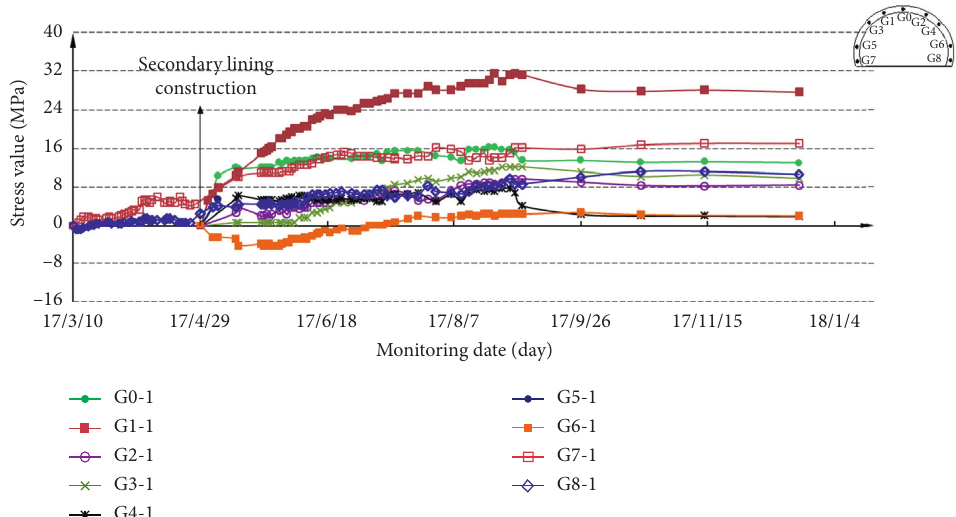
Figure 14: Stress temporal curves of outer side steel bar in secondary lining at section